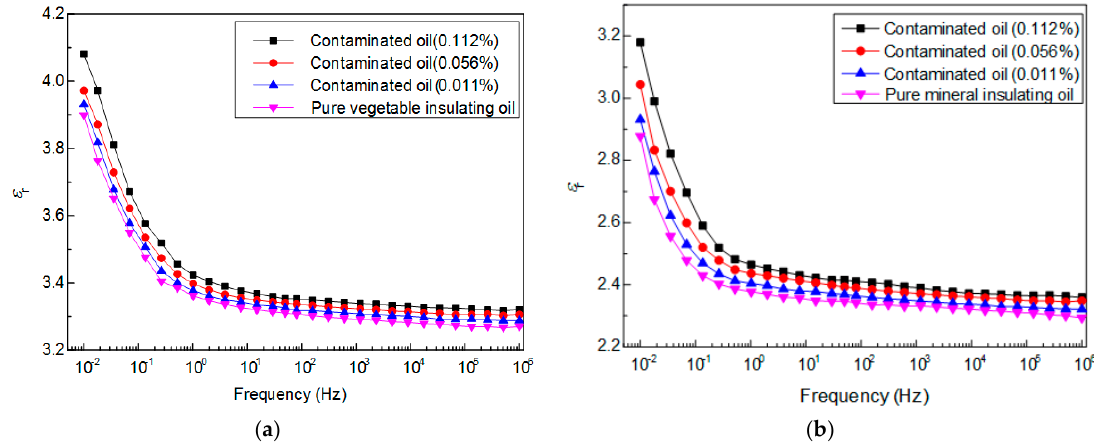
Figure 6. Relative permittivity of ( a ) vegetable insulating oil and ( b ) mineral insulating oil versus frequency with different copper volumetric concentrations.